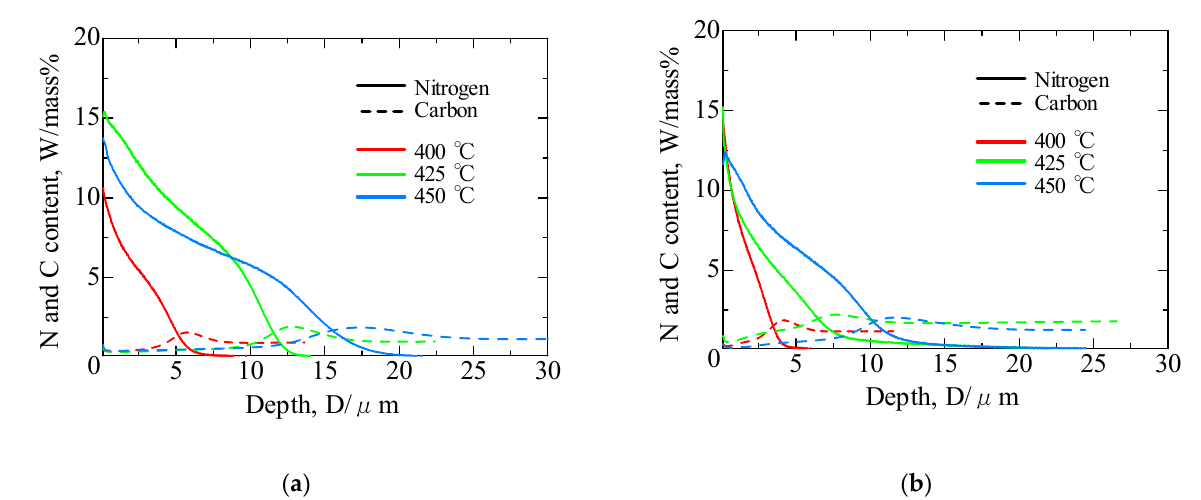
Figure 6. Nitrogen and carbon depth distributions of the AISI 316 L steel-based WC composite layers with various WC compositions and nitriding temperatures: ( a ) WC 20 wt.%, and ( b ) WC 40 wt.%.